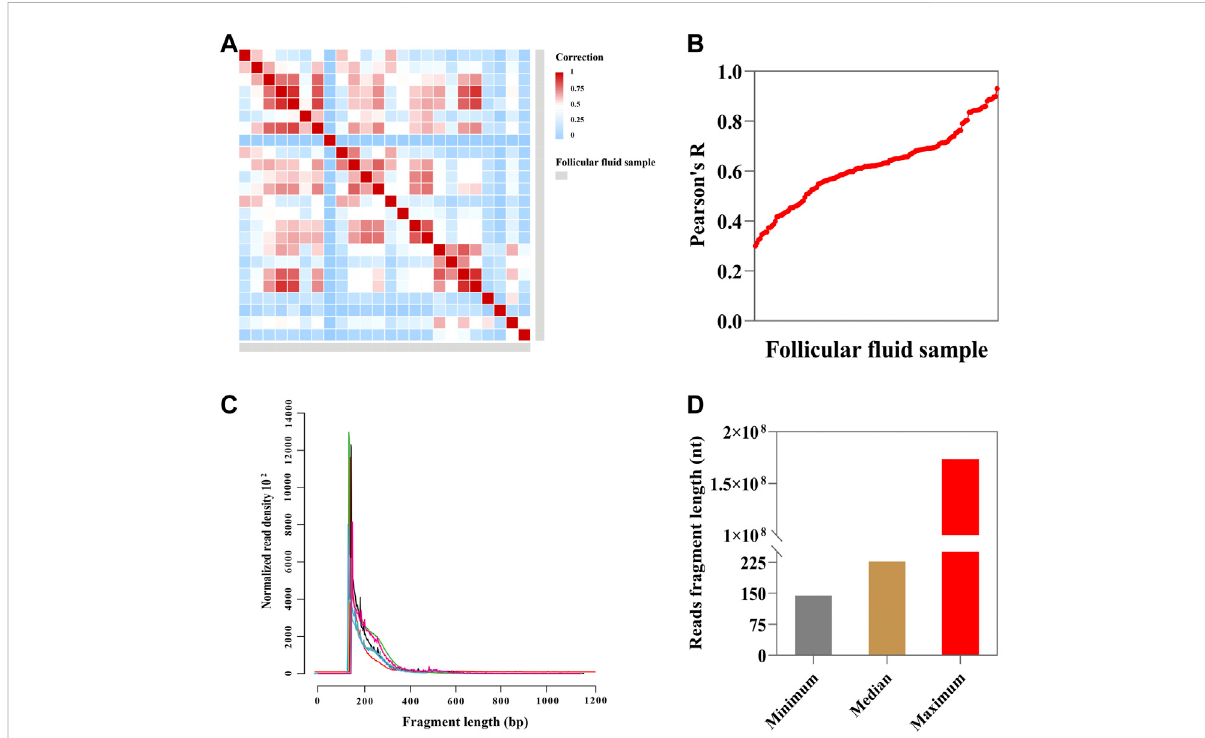
FIGURE 2 Sequencing and descriptive characteristics of reads. (A) Heatmap showing Pearson correlation of FPKM (fragments per kilobase of exon model per million mapped fragments) values (n = 24; blue indicates low correlation and red indicates high correlation); (B) correlation between each follicular fl uid sample (n = 24, Pearson correlation analysis). (C) Fragment size distribution of sequence reads in follicular fl uid (n = 7). (D) Minimum, median, and maximum read fragment sizes of the follicular fl uid (n =